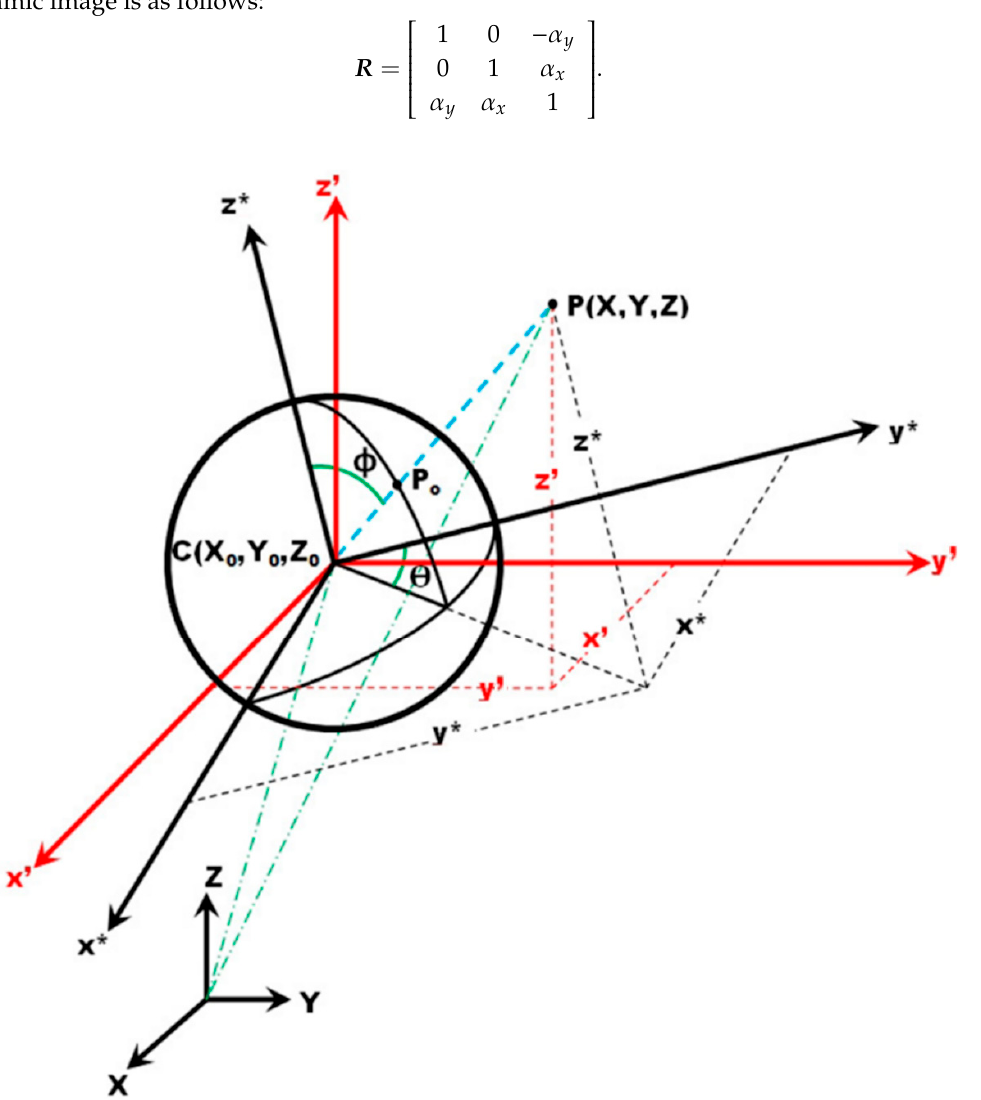
Figure 8. The geometry of a spherical image in 3D space. Collinearity equations can be formulated taking into consideration two additional corrective angles for the lack of verticality.